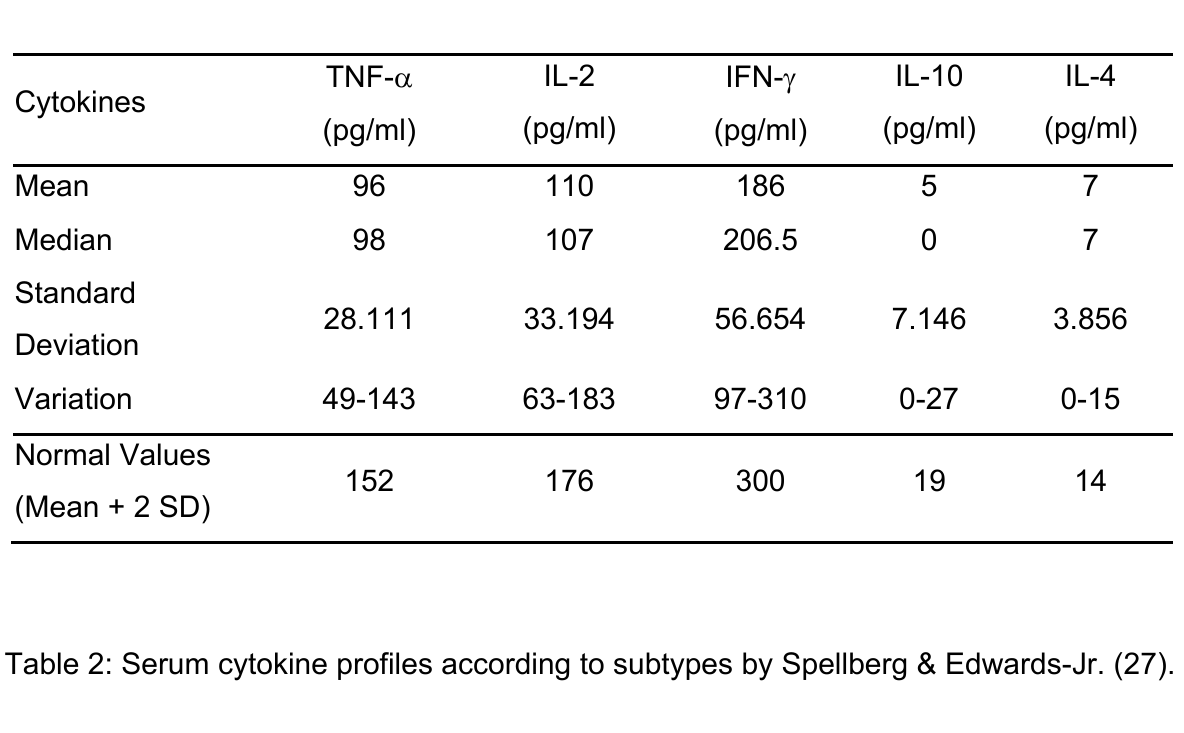
Table 1: Normal values of TNF- α , IFN- γ , IL-2, IL-4, and IL-10 serum cytokines from control group GC-1.